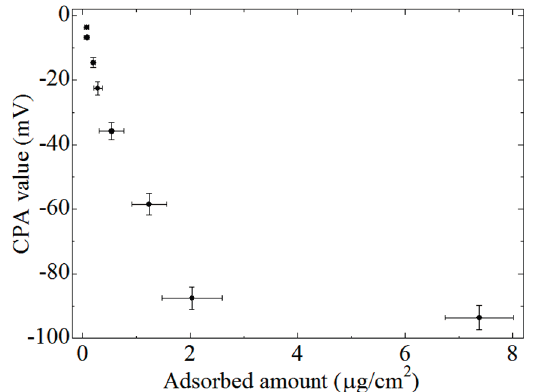
Figure 8. Relationship between the CPA value and the amount of adsorbed EGCg. Data are expressed as mean ± SD (CPA value, n = 16; adsorbed amount, n = 9). The CPA values ware used same data of Figure 3 (1 wt % lipid